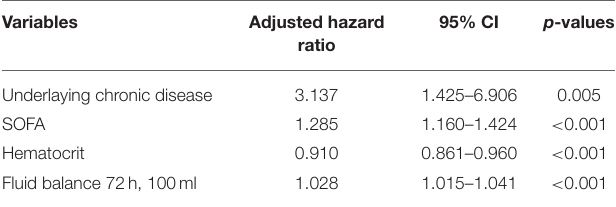
TABLE 4 | Multivariate COX regression analysis of 28-day